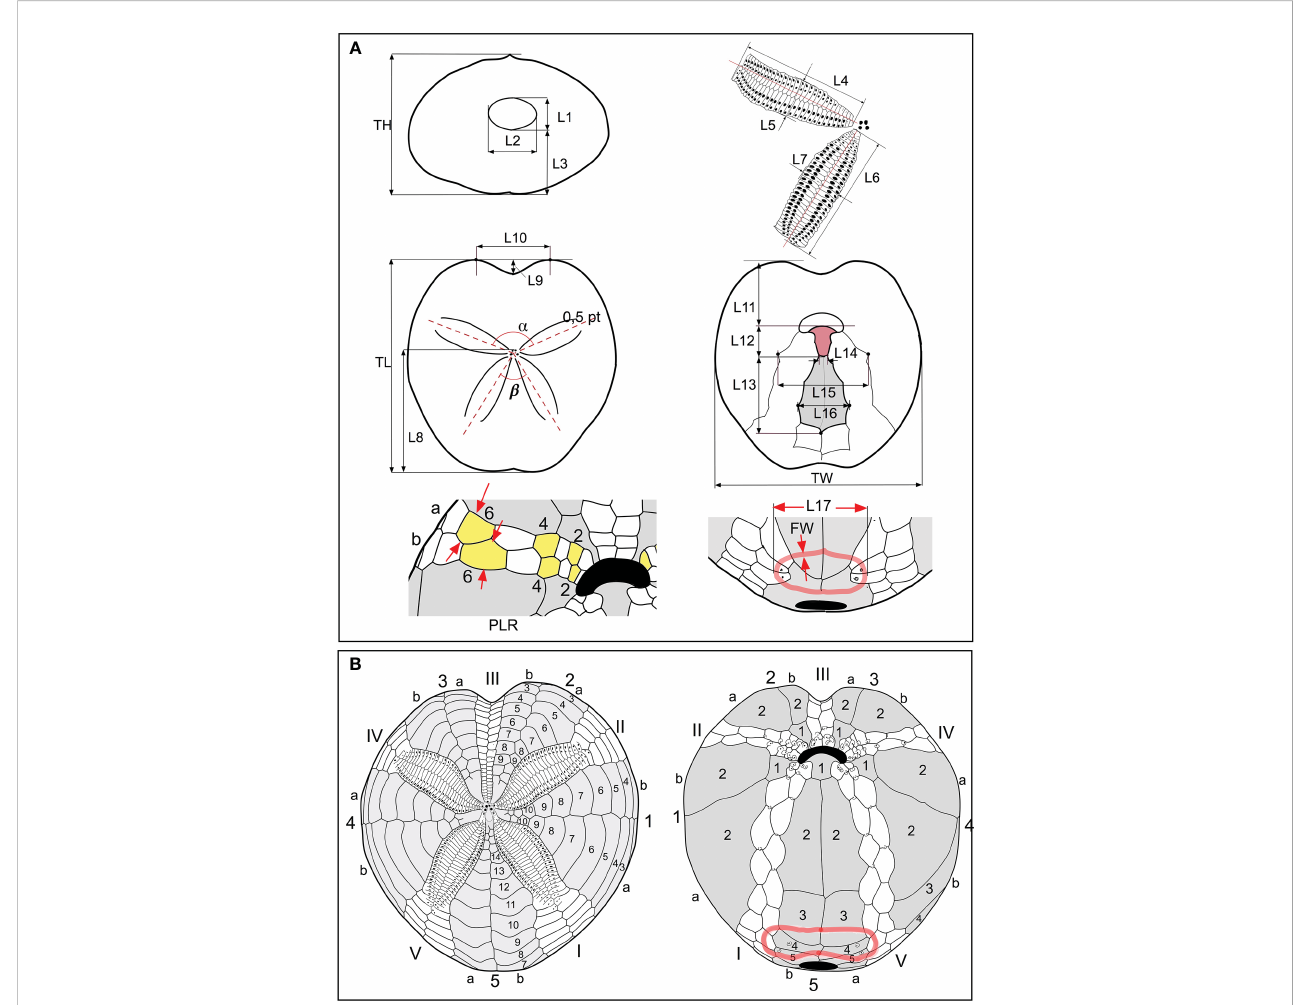
FIGURE 2 (A) Scheme of biometric measurements used in this study. (B) Conventional numbering of plates according to Love ́ n (1874). The ambulacral plates are numbered in Roman numerals; the interambulacral in Arabic numerals. Each area is divided into two columns “ a ” and “ b ” ; the count occurs counterclockwise in the aboral view and clockwise in the oral